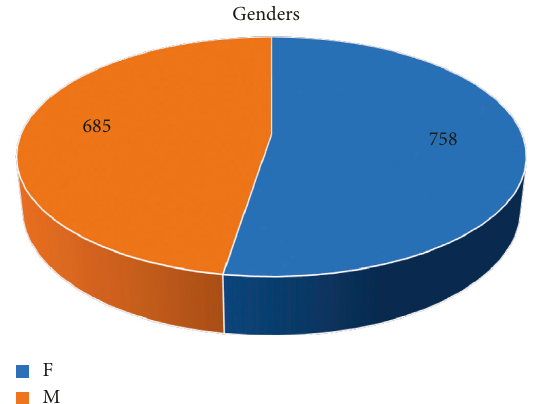
Figure 2: Genders of the patients. The numbers on the pie rep- resent male and female patients in the enrolled population.